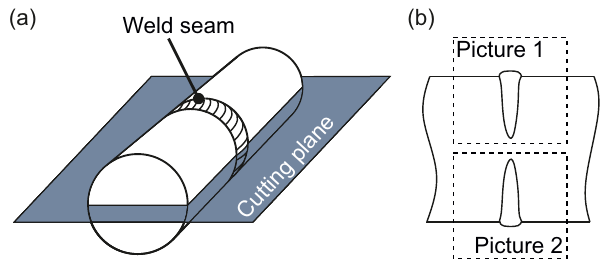
Figure 1. Obtaining images from welds: ( a ) Circumferential welds formed during welding of two cylindrical specimens cut as preparation for metallography. ( b ) Two micrographs resulting from